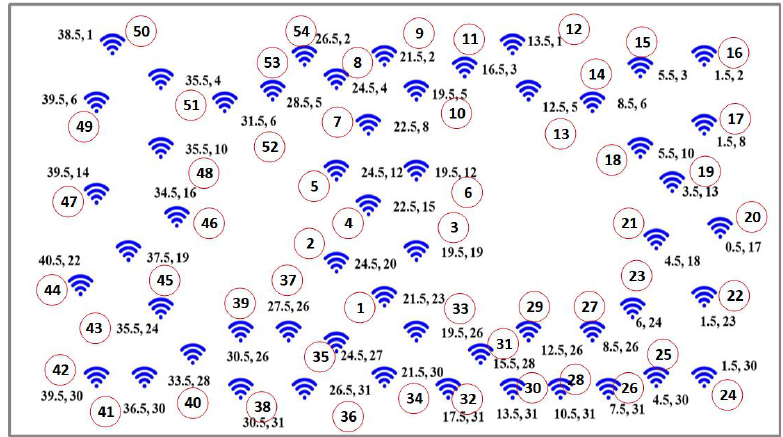
Figure 5. Typical wireless sensor nodes arrangement [48], where wireless sensor nodes are depicted with symbol in ’Blue’ and corresponding node